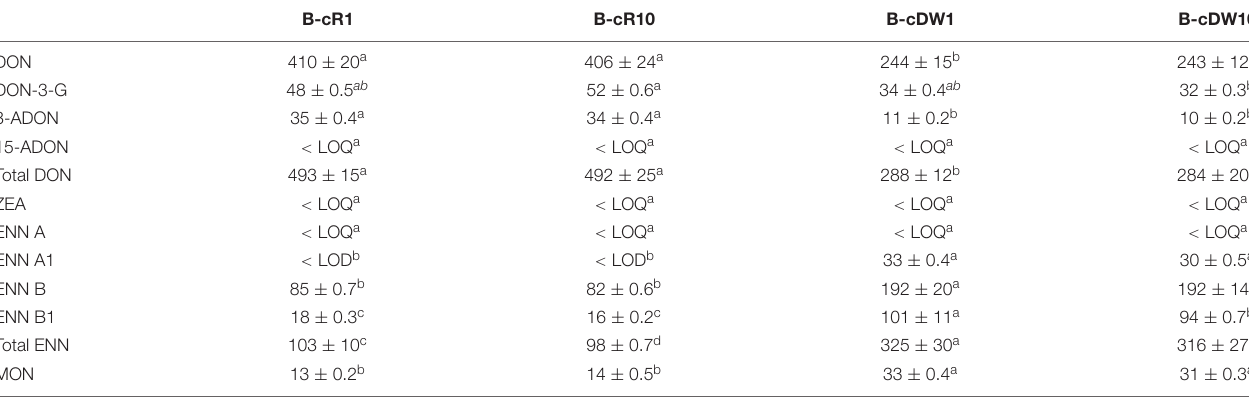
FIGURE 2 | Concentration of asparagine found in doughs prior (cR0, oR0, cDW0, oDW0, cSW0, and oSW0) and after (cR1, oR1, cDW1, oDW1, cSW1, and oSW1) the first fermentation and after 10 days of propagation (cR10, oR10, cSW10, oSW10, cDW10, and oDW10). Lactiplantibacillus plantarum oR4, SW3, and DW9 strains were used as binary starters in association with Pediococcus acidilactici oSW5 to ferment conventional or organic rye (oR4 and oSW5), soft (oSW3 and oSW5), and durum wheat (DW9 and oSW5) flours depending on the source of isolation of L. plantarum strains. Saccharomyces cerevisiae N2 was used as yeast in all samples. Bacteria and yeast were inoculated at final cell density of circa 7 and 6 log10 cfu/g, respectively. The first fermentation (t1) was carried out at 25 ◦ C for 24 h and propagation, through back-slopping (25 ◦ C for 5 h), and lasted 10 days. TABLE 4 | Mycotoxin levels in breads prepared with the sourdoughs obtained after the first fermentation (B-cR1 and B-cDW1) and those after 10 days of propagation (B-cR10 and B-cDW10). B-cR1 B-cR10